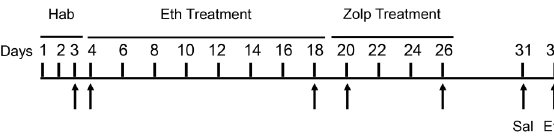
Figure 1. Experimental design. Hab: habituation. Eth treatment: ip injection every other day of saline (Sal) or ethanol (Eth, 1.8 g/ kg). Zolp treatment: ip injection every other day of vehicle or zolpidem (Zolp, 0.5 mg/kg) in the open- fi eld apparatus. Sal challenge: ip injection of saline. Eth challenge: ip injection of ethanol (1.8 g/kg). Arrows indicate days in which behavior was quanti fi